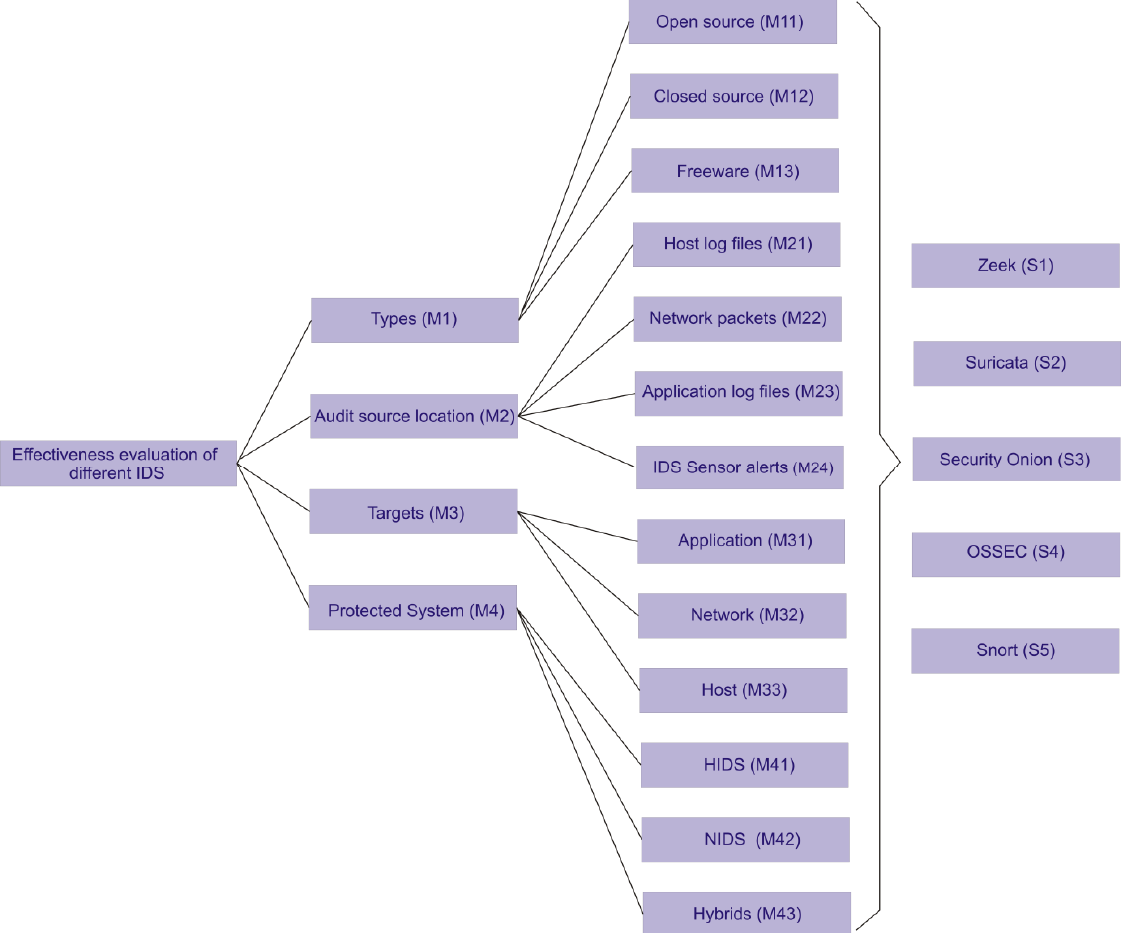
Figure 2. Hierarchy for the effectiveness evaluation of different IDSs.